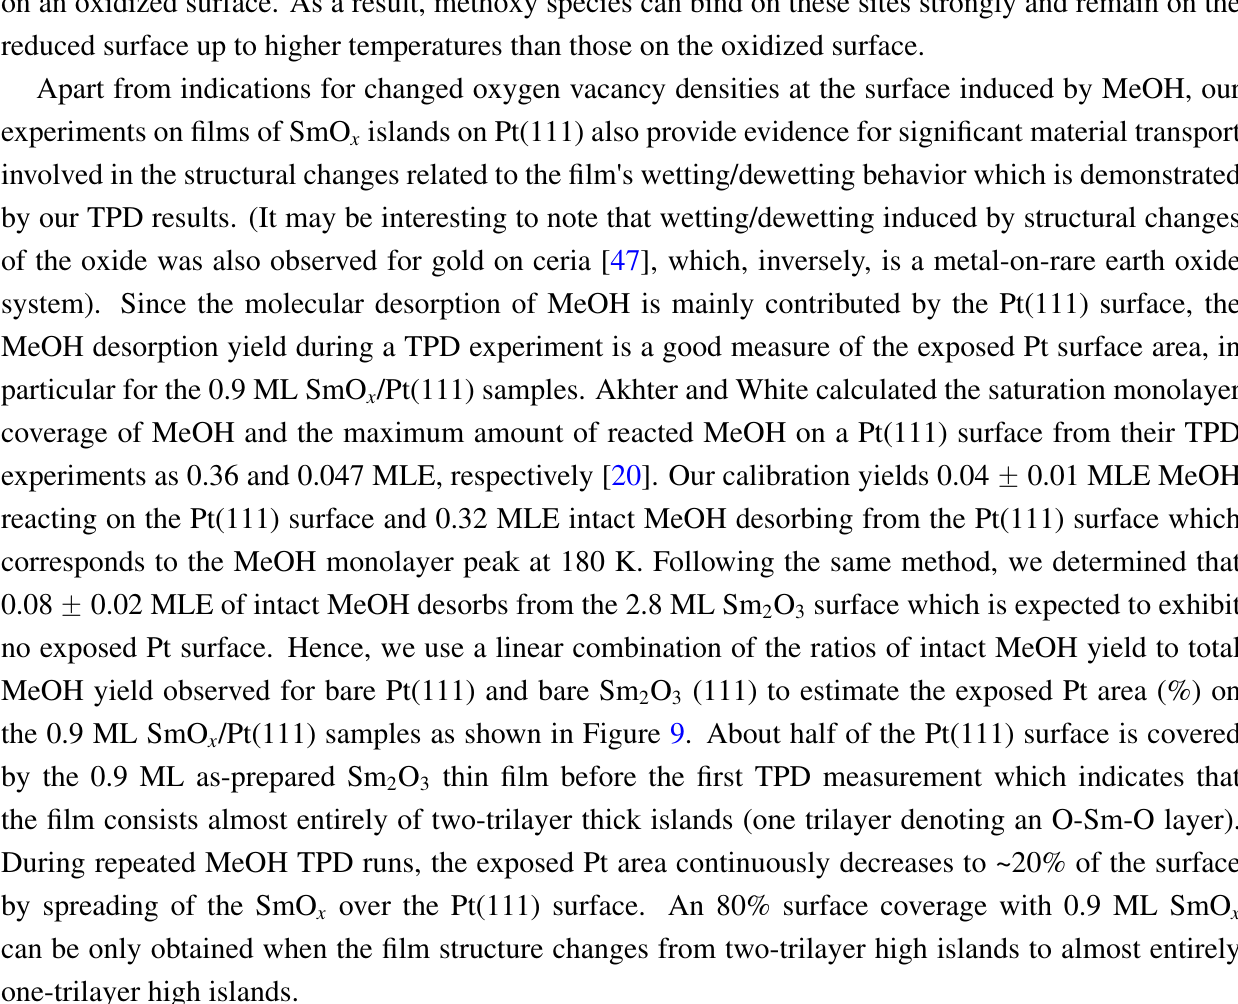
/Pt(111) samples over x